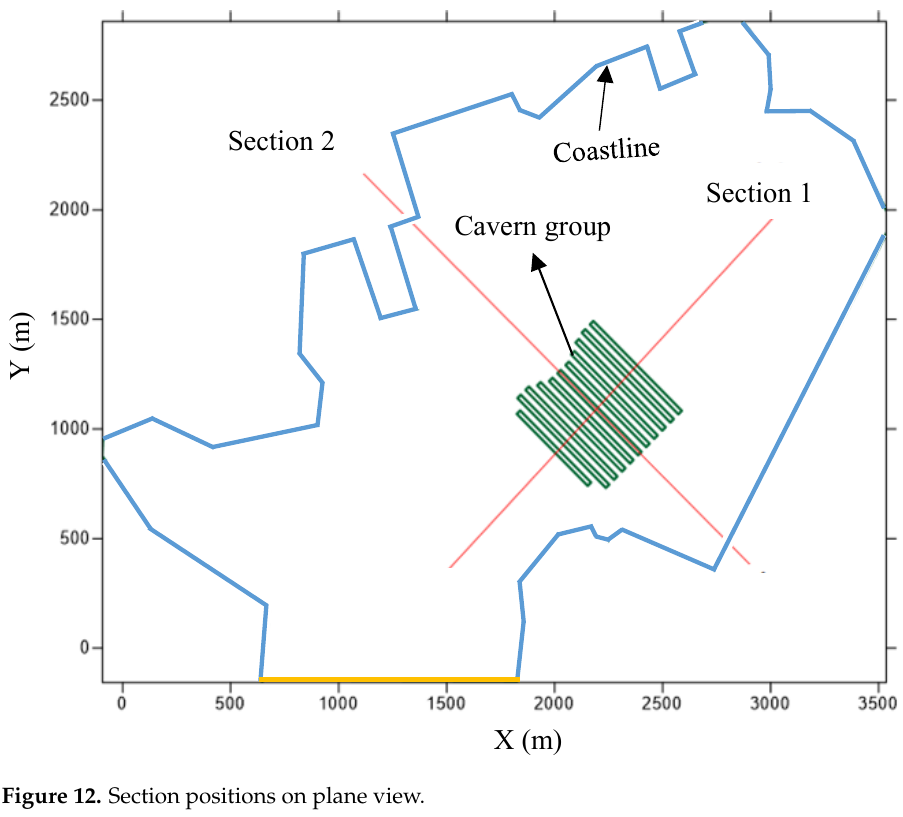
Figure 11. Water head condition after cavern bottom excavation: ( a ) water head contour; ( b ) water head gradient vector diagram.